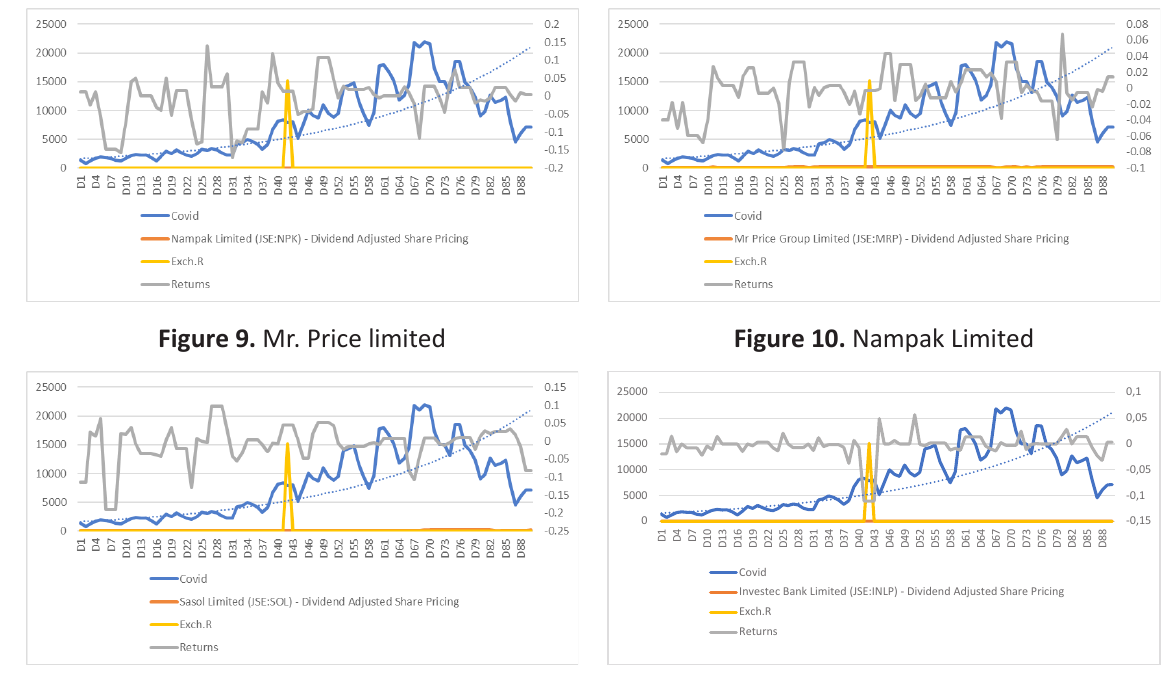
Figure 11. Investec Bank Limited Figure 12. Sasol